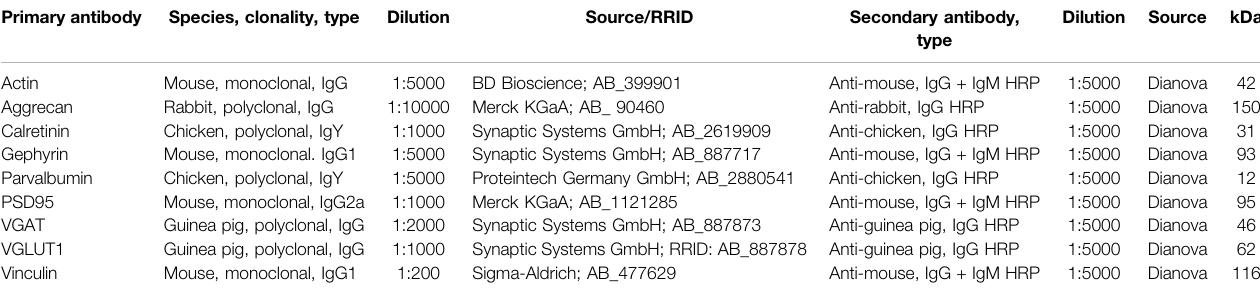
TABLE 3 | List of primary and secondary antibodies for Western blotting. Primary antibody Species, clonality,